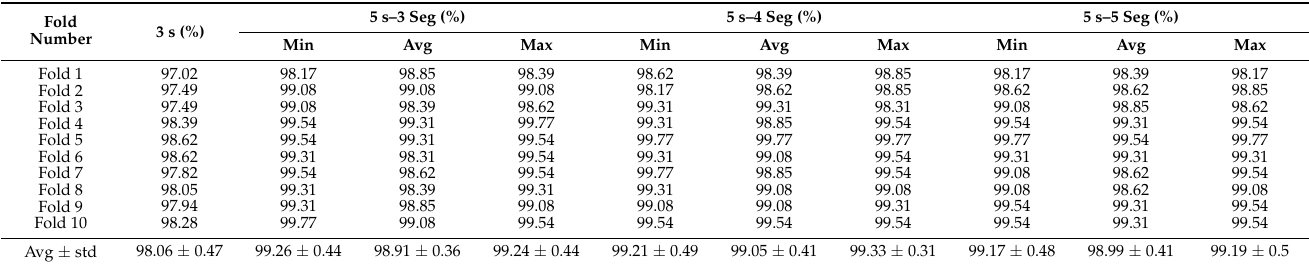
Table 9. Identification System Results (Rank